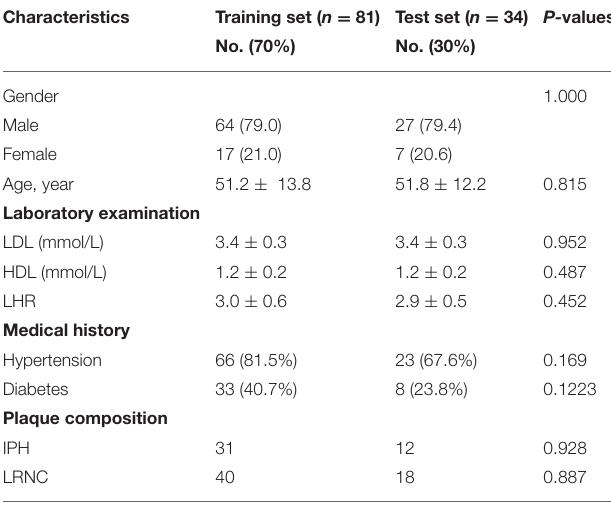
TABLE 1 | Clinicopathological characteristics of patients in the training group and test group.